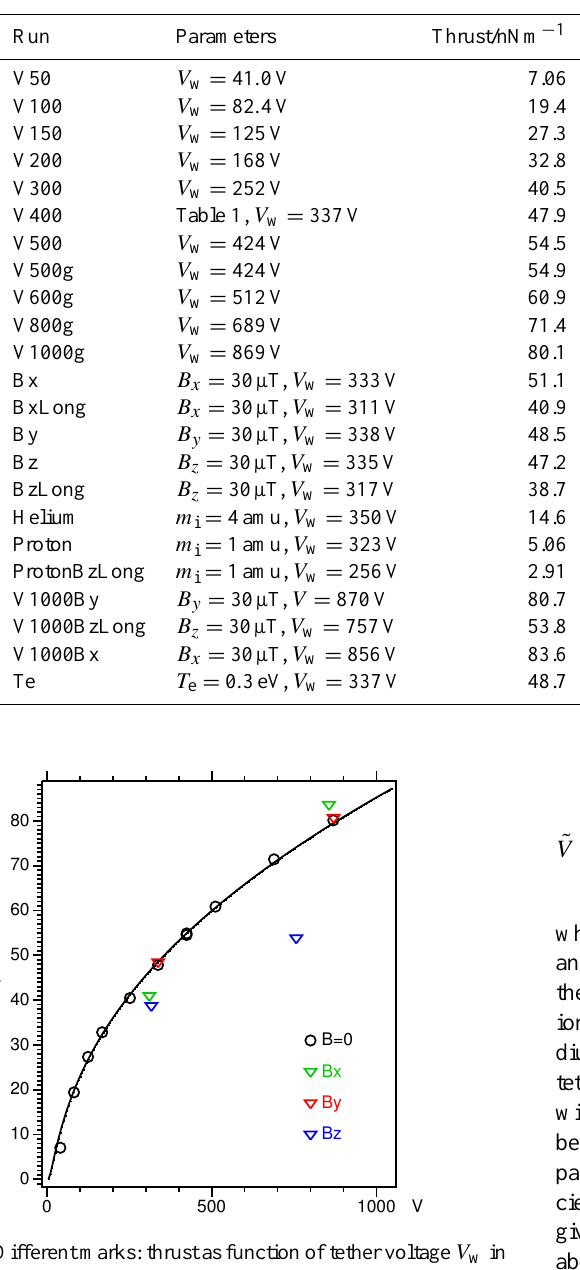
Table 2. List of performed runs. Only differences to run Baseline are mentioned. Runs ending with “g” have larger 768 × 768 grid. The Long runs have 23.4ms duration. The “Rel. thrust” column tells how much the thrust differs from Eq. (1) prediction.